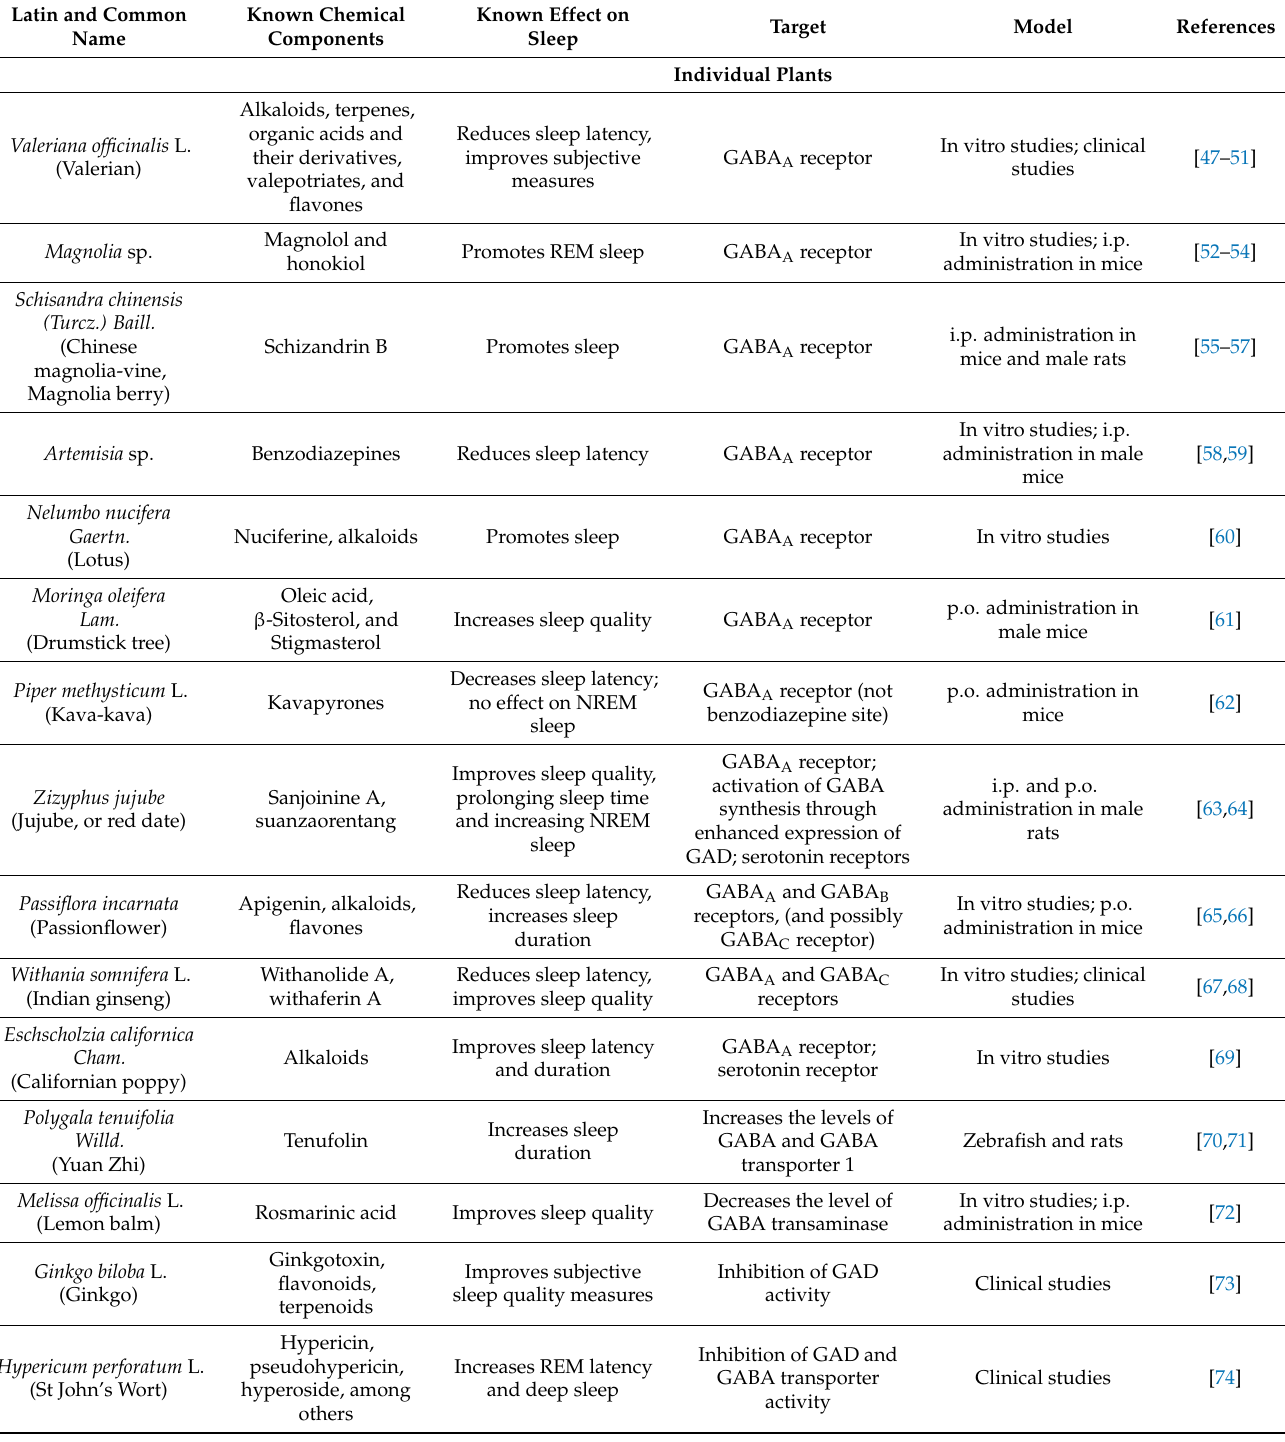
Table 1. Common medicinal plants with known sleep-inducing properties that target GABAergic